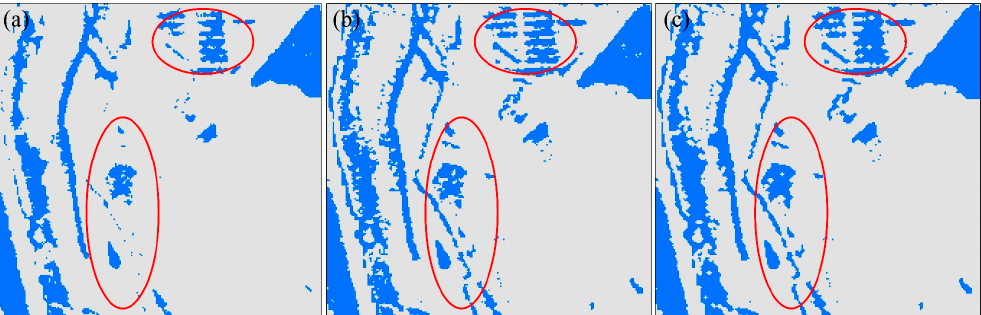
Figure 11. ( a ) Result obtained by the Refined Lee filter before water body extraction, ( b ) result of original image, ( c ) result obtained by morphological operators (first erosion, then dilation) after water body extraction.